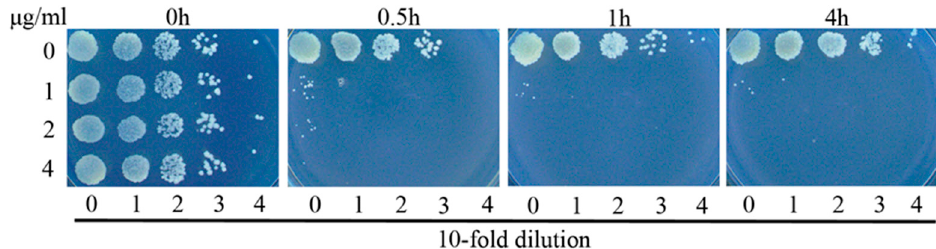
Figure 2. Complex 3 is bactericidal against M. smegmatis . Bacterial cells were inoculated in 7H9 medium, and cultured either without drug or in the presence of 3 at various concentrations. At the indicated time points, aliquots of cell suspension were transferred and plated on drug-free 7H9 medium CFU after 24 more hours of incubation.